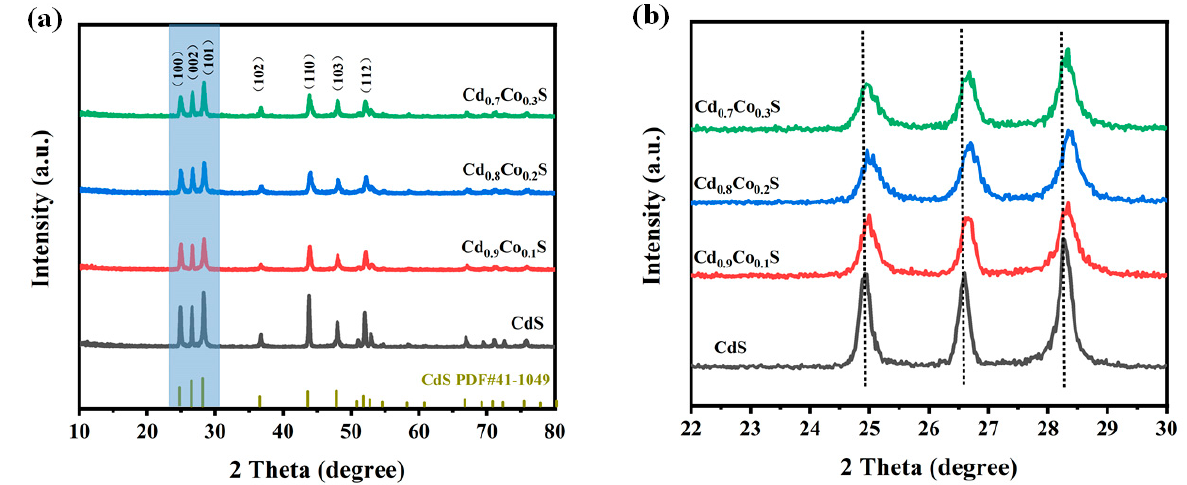
Figure 1. The XRD patterns ( a ) and partially magnified XRD patterns of pure CdS and CdCoS NRs ( b